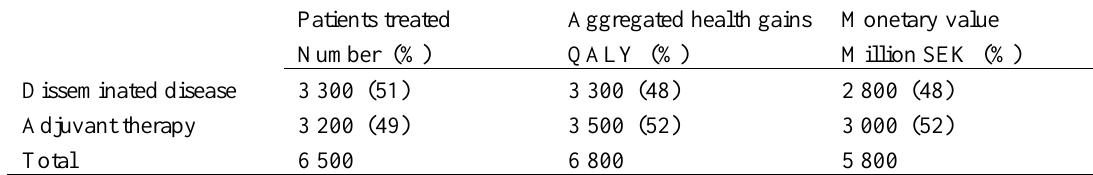
Number of patients treated, aggregate health gains measured as QALYs, and monetary value of health gains (million SEK) from trastuzumab in Sweden years 2001−2011. Source Lundqvist et al (2013b). Patients treated Aggregated health gains Monetary value Number (%) QALY (%) Million SEK (%) Disseminated disease 3 300 (51) 3 300 (48) 2 800 (48) Adjuvant therapy 3 200 (49) 3 500 (52) 3 000 (52) Total 6 500 6 800 5